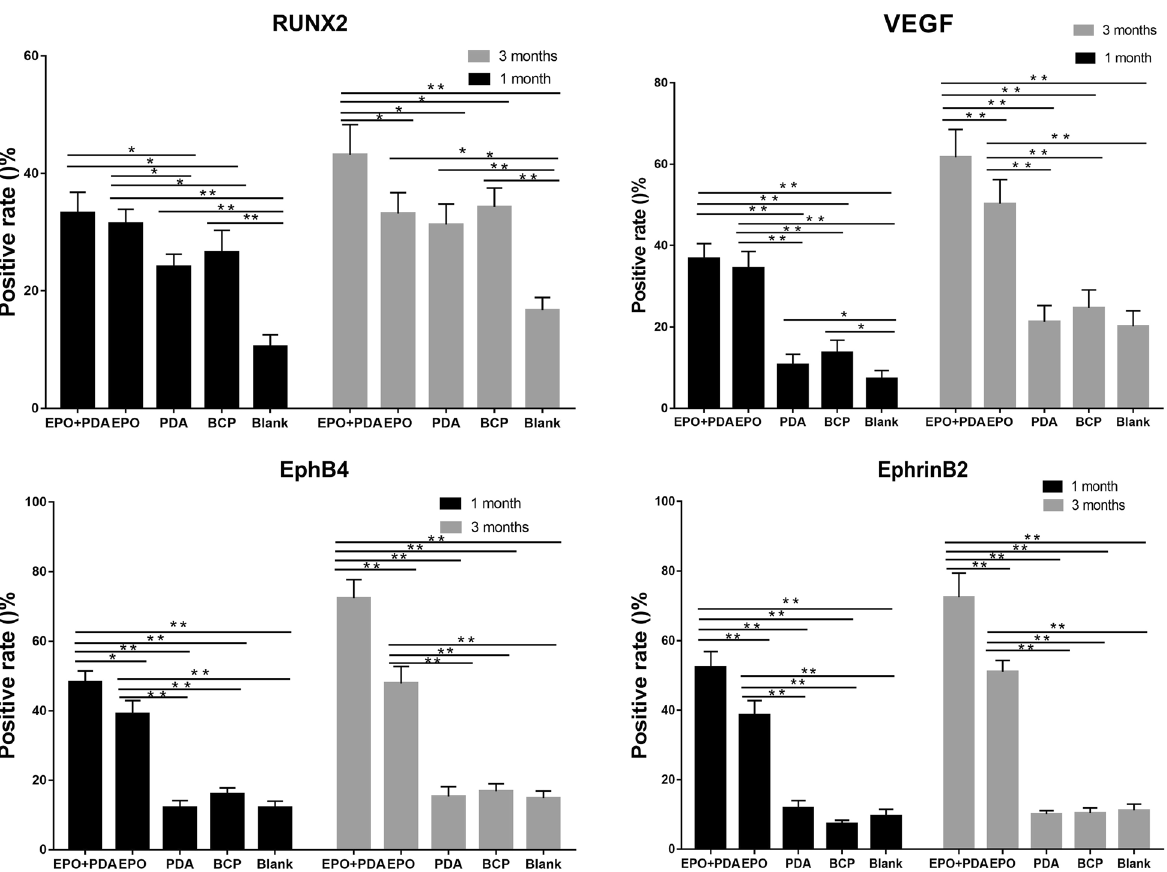
Fig. 10 Quantitative analysis of immuno-histochemical staining of RUNX2, VEGF, EphB4, and EphrinB2 proteins 1 and 3 months post operation. (** p < 0.01, * p <